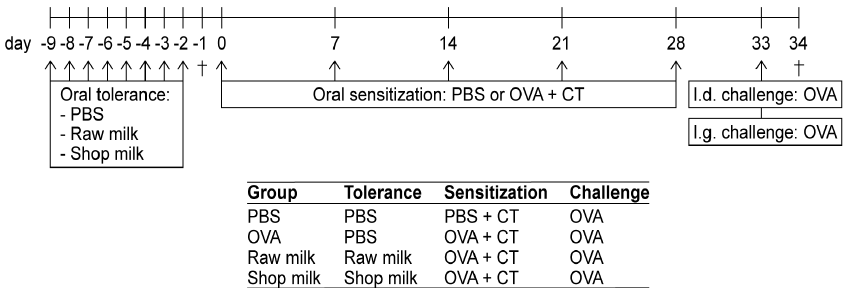
Figure 1. Schematic representation of the experimental timeline. For epigenetic measurements, additional groups of mice were killed after the tolerance induction period (day − 1) and after both challenges (day 34; as indicated by †). PBS, phosphate ‐ buffered saline; OVA, ovalbumin; CT, cholera toxin; i.d., intradermal; i.g., intragastric.